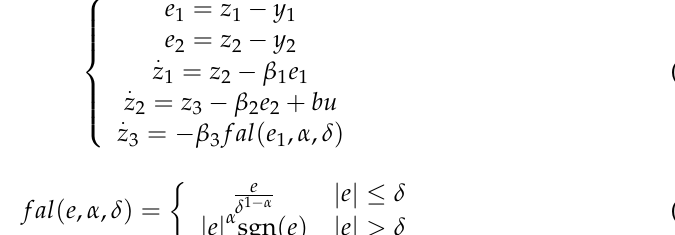
Figure 8. The improved active disturbance rejection control framework.